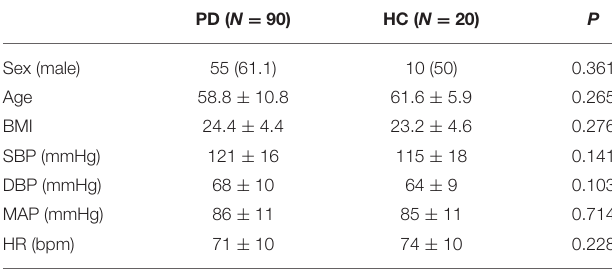
TABLE 1 | Demographic feature between each